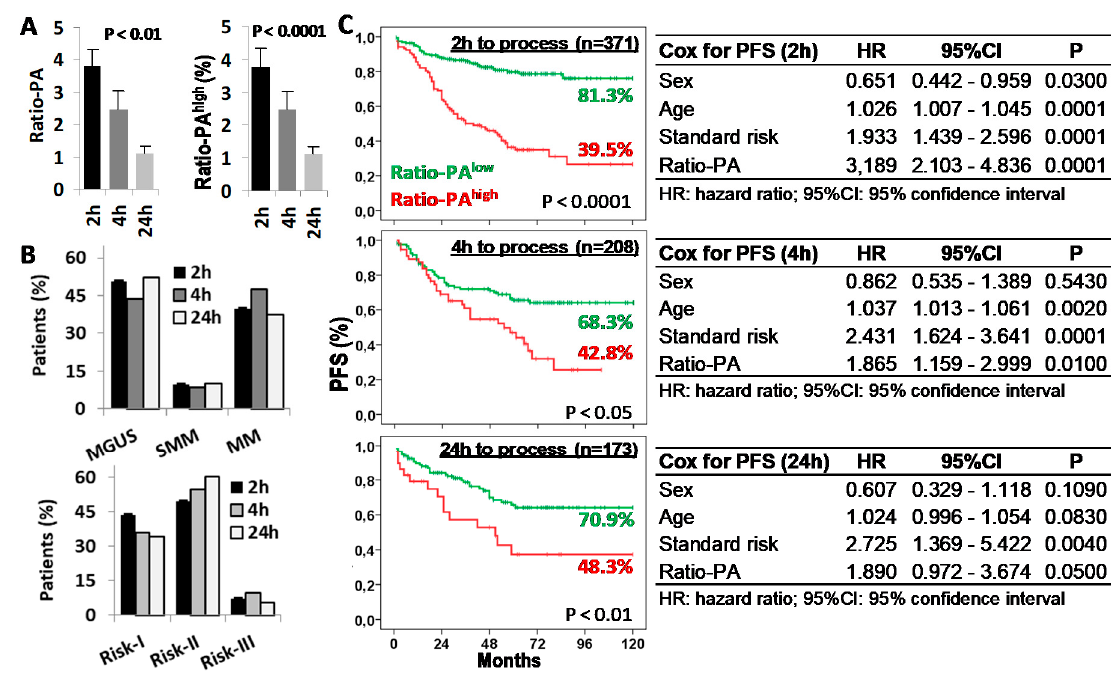
Figure 5. Time from bone marrow (BM) extraction to laboratory processing reduces the prognostic capacity of the Ratio-PA. ( A ) Ratio-PA of BM plasma cells and proportion of patients with Ratio-PA high for samples processed 2 h, 4 h, or 24 h after BM extraction. ( B ) Distribution of patients by the plasma cell neoplasm (PCN) stage and the standard risk (Risk) group according to the processing time. ( C ) Kaplan-Meier and Log-rank tests for progression-free survival (PFS) according to Ratio-PA (high/low) in total PCN patients and according to the time until processing; and Cox regression analysis of PFS for sex, age, standard risk stratification, and Ratio-PA for samples processed 2 h, 4 h, or 24 h after BM extraction.